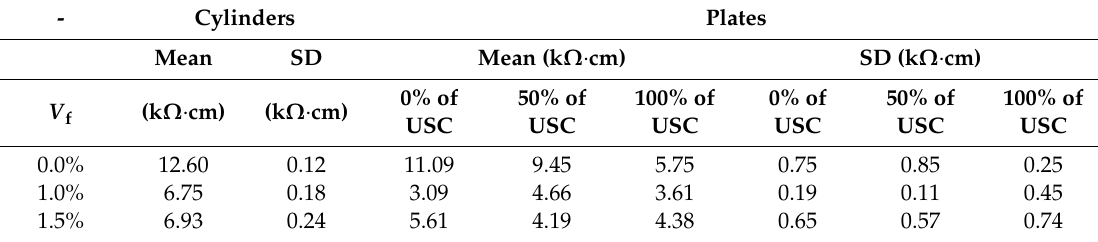
Figure 6. Bulk resistivity of standard cylinders and plates with di ff erent amount of fibre ( V f ) and values of load (USC). Table 4. Results of bulk resistivity of SLWAC in the form of mean value and standard deviation.